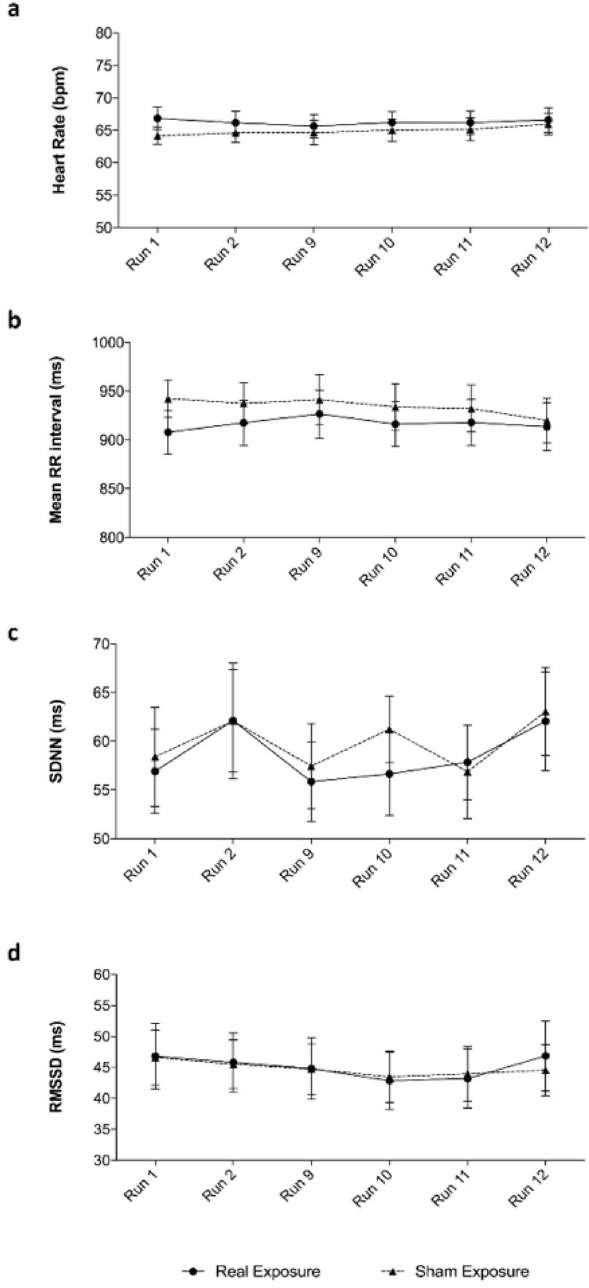
Figure 5. Results of ECG analysis. Heart rate data are show as means ± SEM ( a ). Heart rate variability data are show as means ± SEM and were estimated in time-domain: mean RR interval ( b ), standard deviation of the RR intervals, SDNN ( c ), square root of the mean squared differences between successive RR intervals, RMSSD ( d